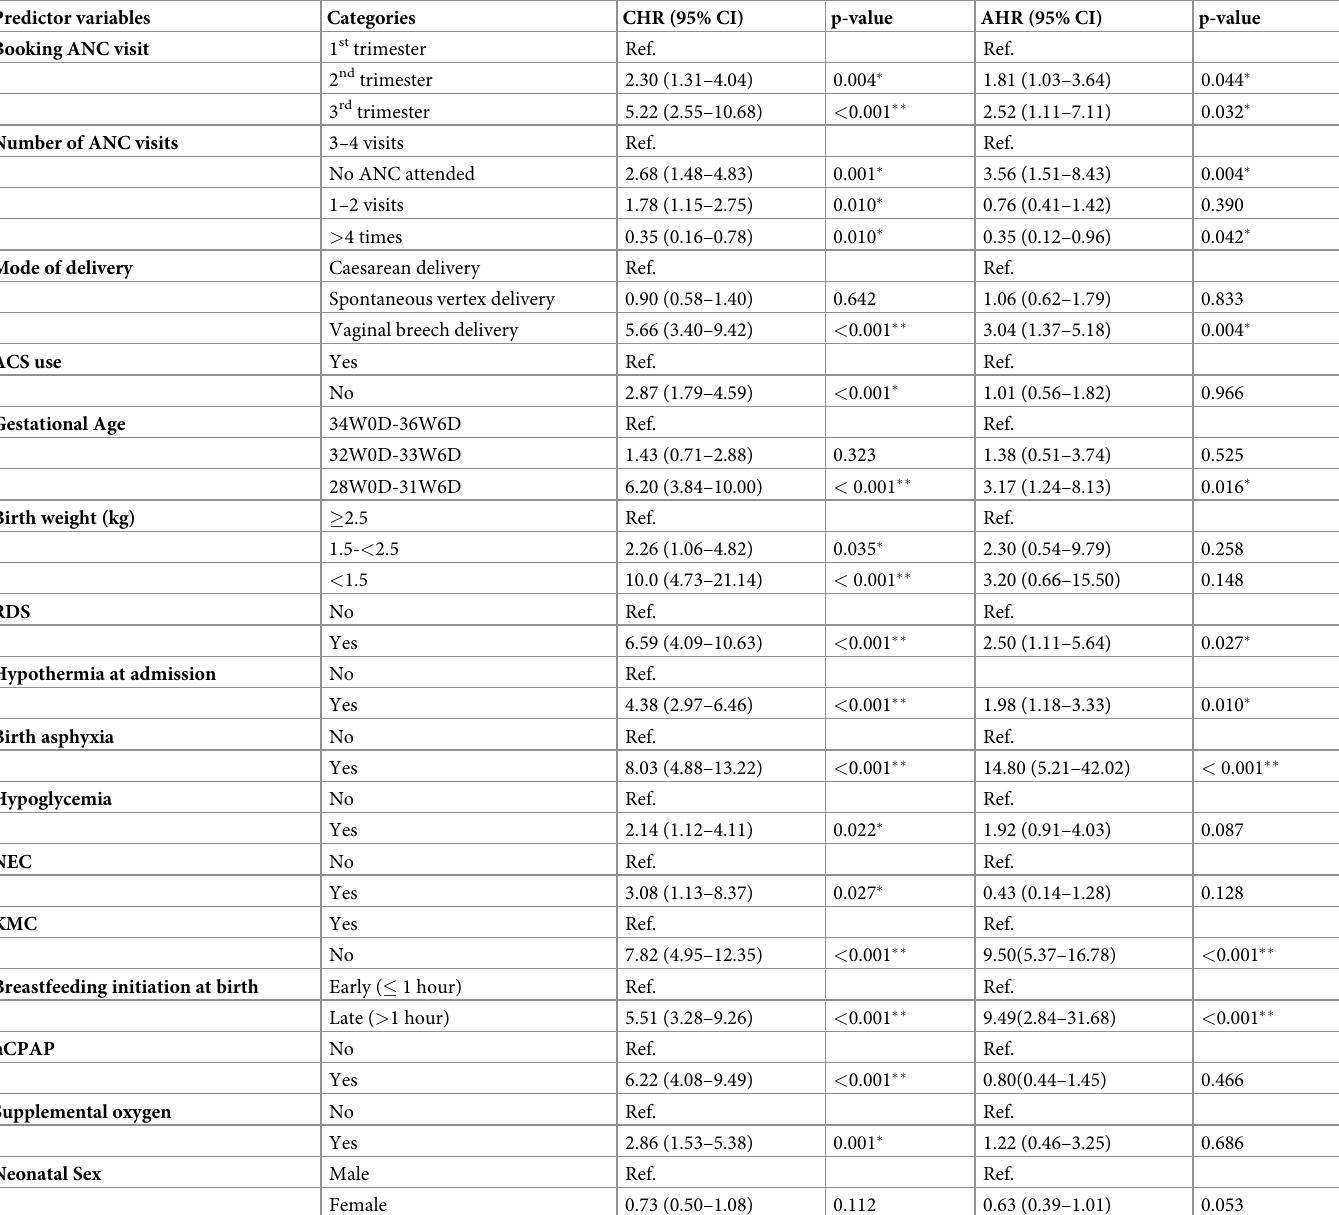
Table 4. Predictors of mortality among preterm neonates born at Mbarara Regional Referral Hospital from October, 2019 to September, 2020. Predictor